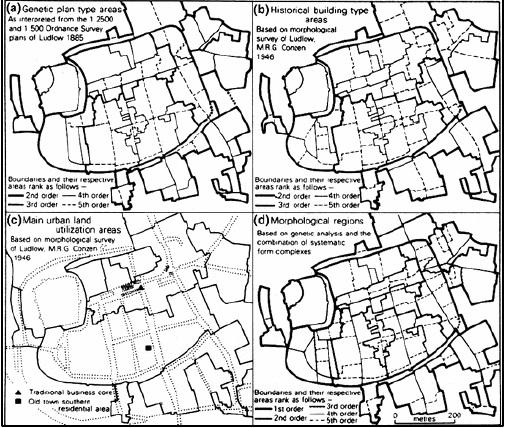
Figure 2 Morphological regions of Conzen’s Ludlow map (Whitehand,